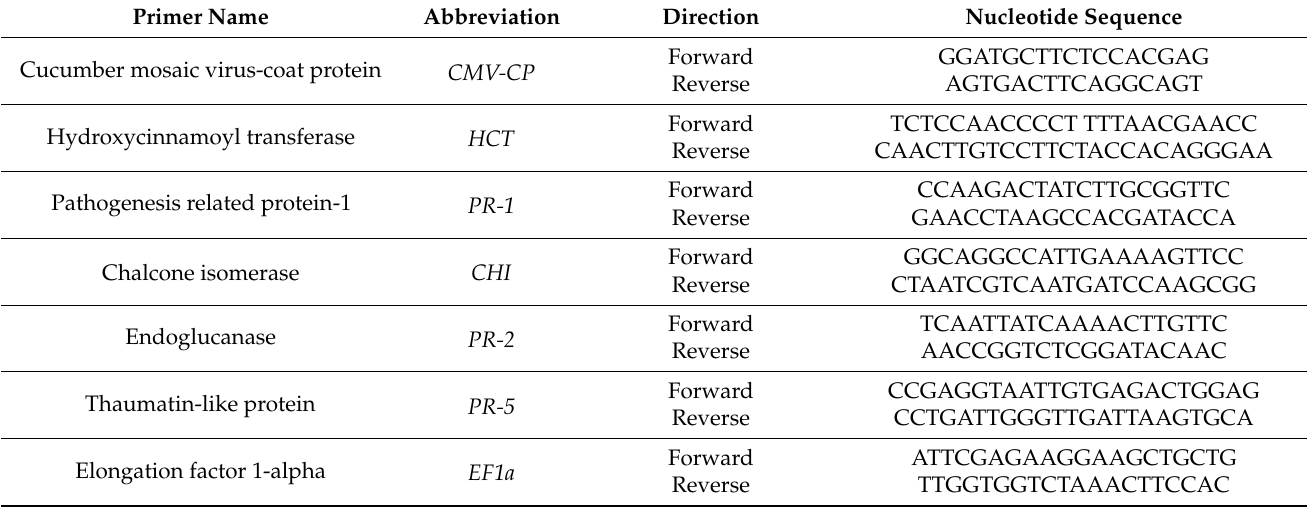
Table 1. Nucleotide sequences of primers used in this